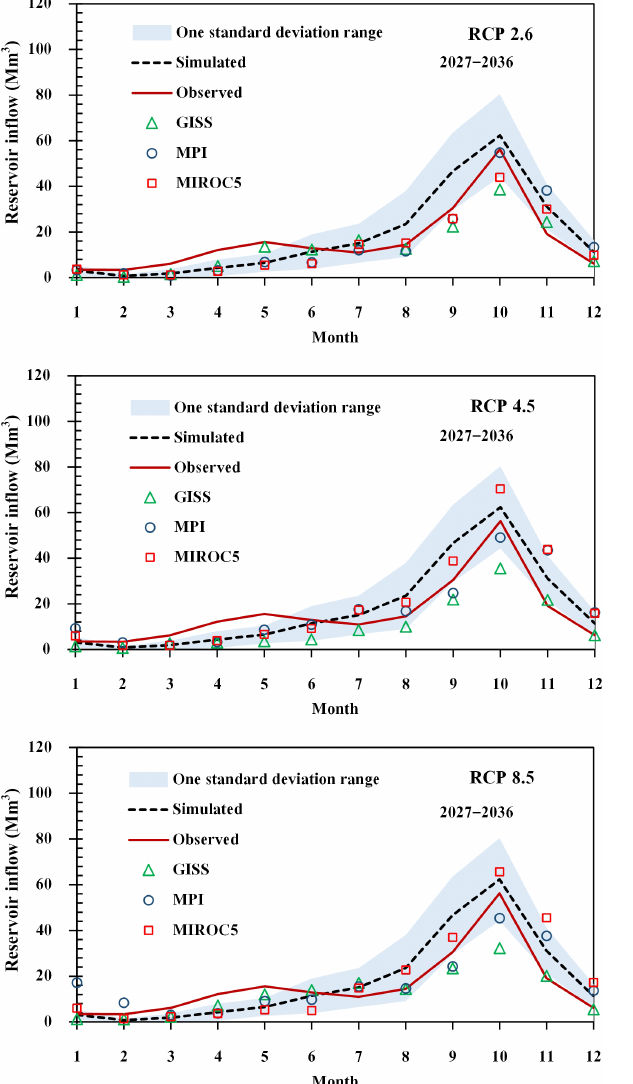
Figure 12. Projected mean monthly reservoir inflows under 3 sce- narios for the years 2017–2026 at Klong Yai